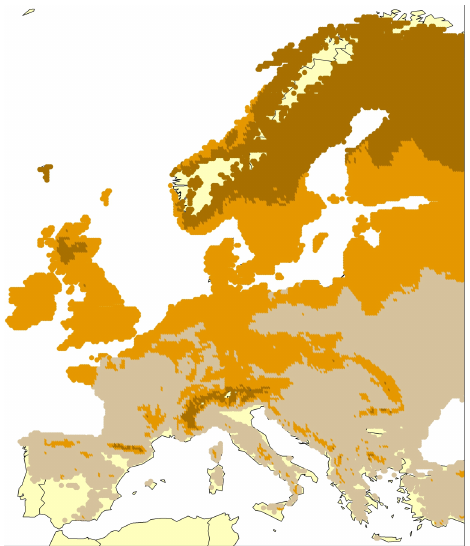
Figure 3. Example for the projections used in PRONAS: projected areas for the European peacock ( Nymphalis io ) assuming scenario Red for the year 2080 (Settele et al.,